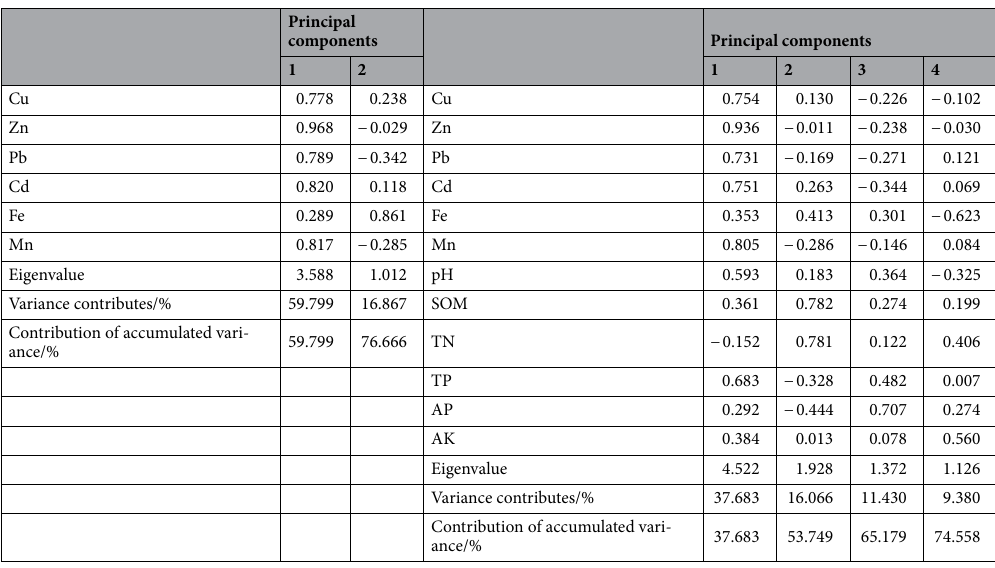
Table 2. Loadings of heavy metals and soil physicochemical properties on principal components for 81 soil